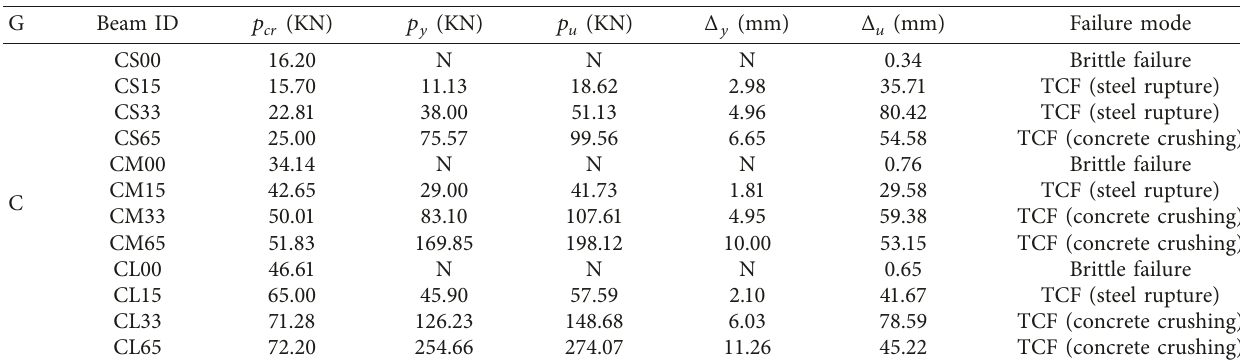
Figure 8: Typical location of LVDT and strain gauges on beam specimens. Table 8: Results of the tested